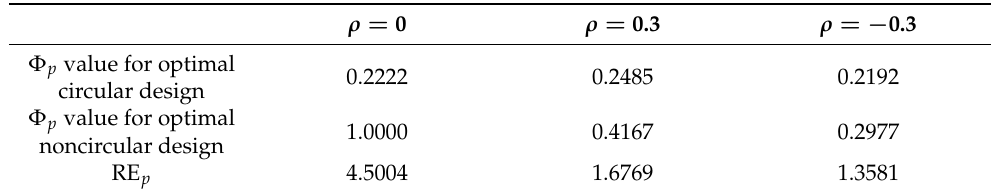
Table 1. Comparison of the Φ p for optimal designs under circular and noncircular setups